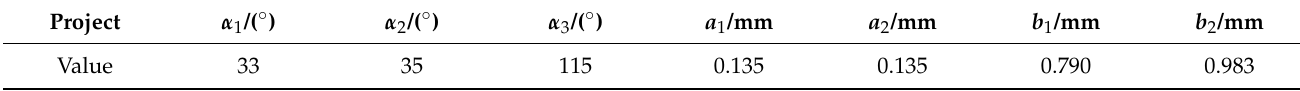
Table 2. Design values of characteristic